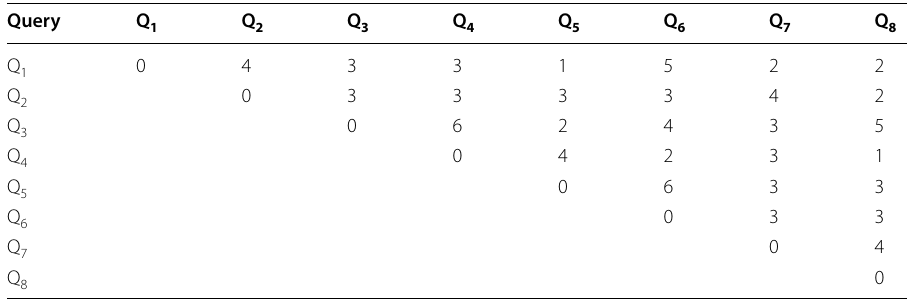
Table 5 Query Difference Matrix